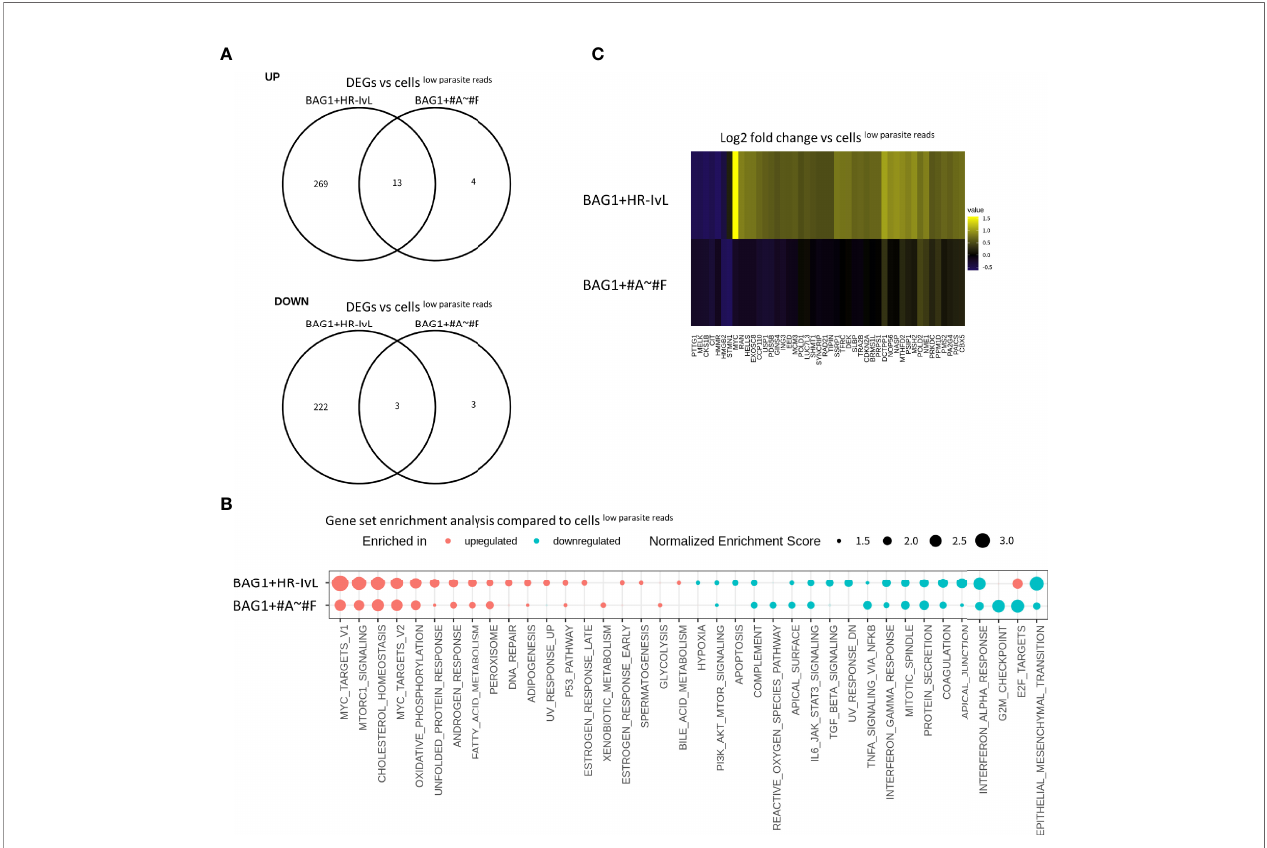
FIGURE 6 | Heterogeneity exists in the cells containing T. gondii SAG1 − /BAG1+ . (A) DEGs detected in BAG1+HR-IvL vs. cells low parasite reads and BAG1+#A – #F vs. cells low parasite reads were compared in Venn diagrams. Log 2 fold change of 0.5 and FDR of 0.05 were used to estimate DEGs. (B) Normalized enrichment scores for gene set enrichment analysis (GSEA) are shown. Pathways with FDR less than 0.05 in at least one of the comparisons are shown. Pathways with FDR <0.05 are shown as solid color circles. (C) Heatmap visualization of genes in E2F target pathway. Log 2 fold change values for each gene are shown with pseudo color. Only genes with absolute values of log 2 fold change over 0.5 in at least one of the comparisons are